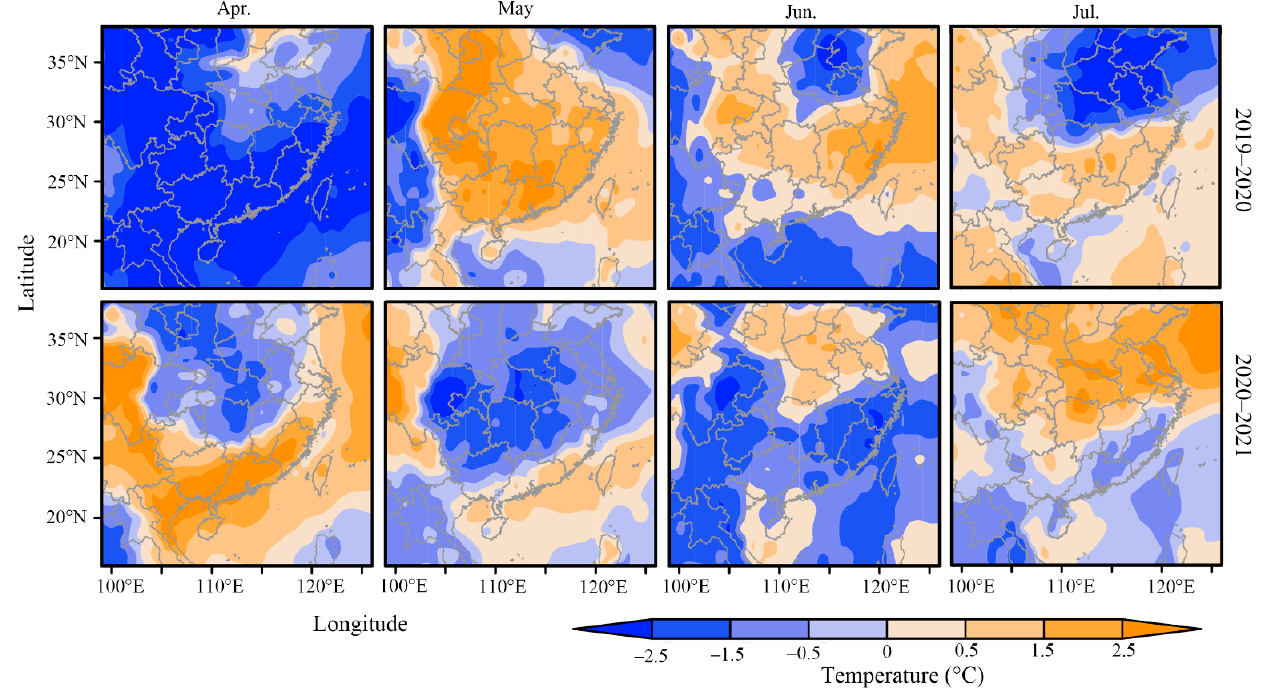
Figure 7. Difference of monthly average temperature in Southern China from April to July in adjacent year.